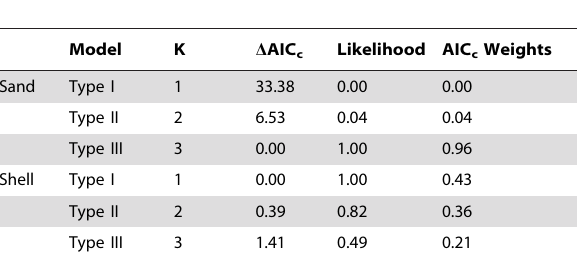
Table 1. Ranking of functional response models in sand and shell habitats using AIC c .